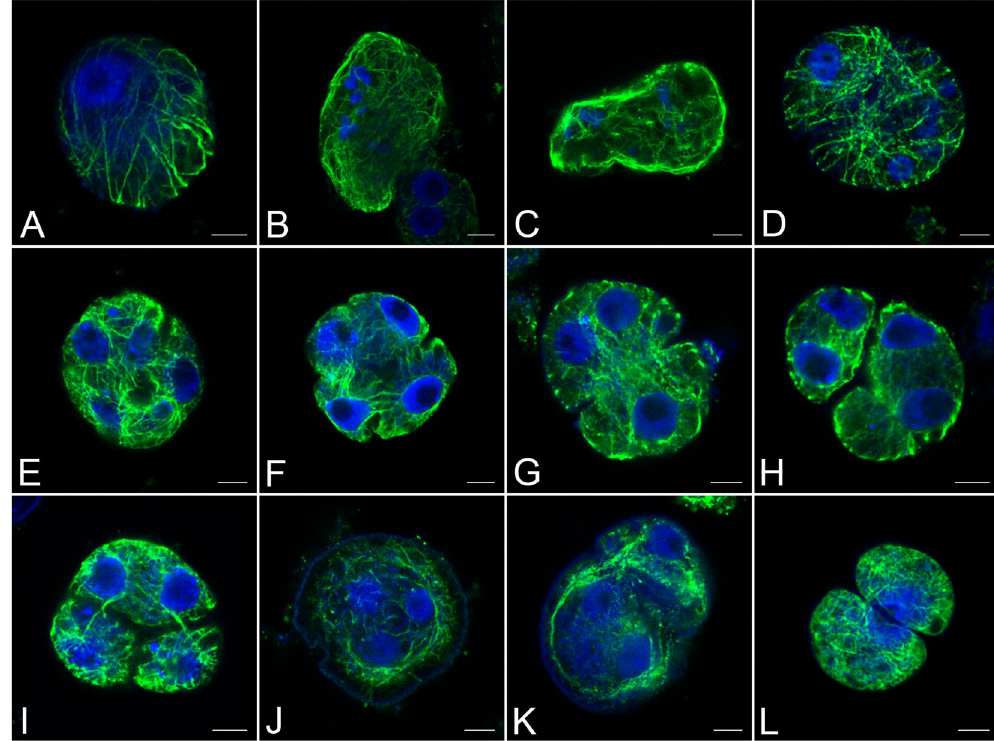
Figure 7. Restoration of microtubules after transferring heat-treated buds to normal conditions. ( A ) Several thick microtubular bundles reformed around the nucleus in prophase I after transferring to normal conditions for 18 h. ( B , C ) Repolymerised microtubular array instead of spindles in the cytoplasm of metaphase I ( B ) and metaphase II ( C ) cells after 12 h transferred. ( D ) Repolymerisation of microtubules in telophase II after 12 h transferred. ( E ) Formation of new microtubular networks and radial microtubule systems (RMSs) in a treated telophase II cell. ( F ) Cytoplasmic infurrowing between daughter nuclei. ( G–K ) Aberrant cytokinesis due to defects in the new RMSs between daughter nuclei. ( G ) A dyad with two unseparated nuclei in one microspore and one fused nucleus in the other microspore. ( H ) A dyad with one microcyte, showing two unseparated nuclei in each microspore. ( I ) A triad showing two nuclei in one microspore. ( J ) A monad resulted from failure in cytokinesis. ( K ) Unbalanced dyad (one nucleus in one microspore and three nuclei in the other microspore), showing a lack of RMSs between the unseparated nuclei. ( L ) An infurrowed cell with one shared fused nucleus. Bars = 5 μ